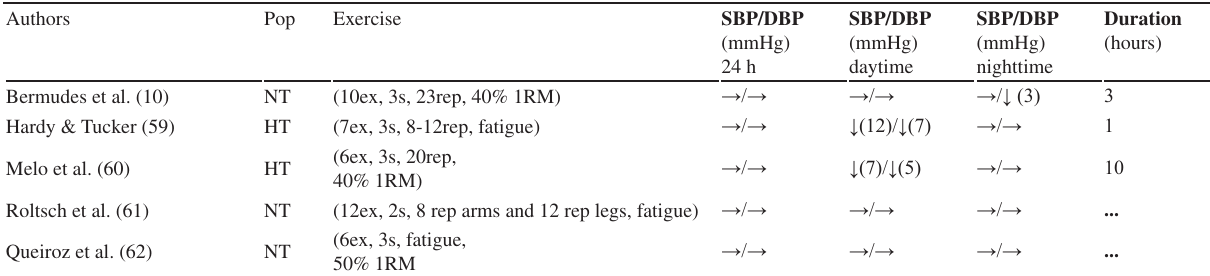
Table 3 - Effects of resistance exercise on ambulatory blood pressure